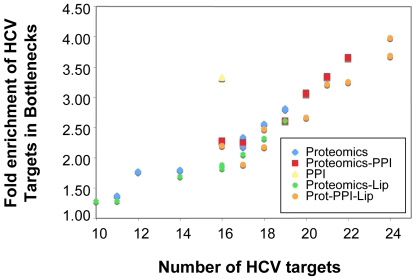
Integration of different network types improves identification of important nodes in HCV infection.Topology of the networks was calculated to identify topological bottlenecks, which were then evaluated for statistical enrichment in proteins known to be targets of HCV proteins by IMAP [46]. The number of identified targets (X axis) is shown against the overall fold enrichment of targets in bottlenecks relative to the rest of the network. The results show that integrating different networks improves the ability to detect these important proteins, and implies that bottlenecks not known to be direct targets of HCV might be playing important roles in the host response process. The networks are: PPI, human protein-protein interactions limited to those between proteins identified by proteomics; Proteomics, correlation-based network from proteomics abundance data; Proteomics-PPI, combined network of proteomics and PPI networks; Proteomics-Lip, combined network of proteomics and lipidomics; Prot-PPI-Lip, combined network of proteomics, PPI and lipidomics.